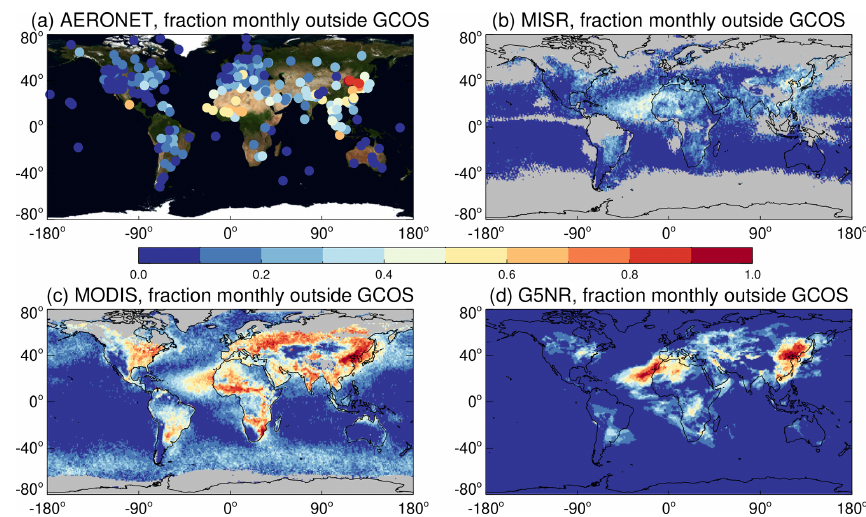
Figure 10. Fraction of months where the difference between arithmetic- and geometric-mean AOD is larger than the GCOS goal uncer- tainty for an AOD climate data record; i.e. |¯ τ l − ¯ τ n | ≥ max [ 0 . 03 , 0 . 1 ¯ τ l ] . Panels show results for (a) AERONET, (b) MISR, (c) MODIS, and (d)